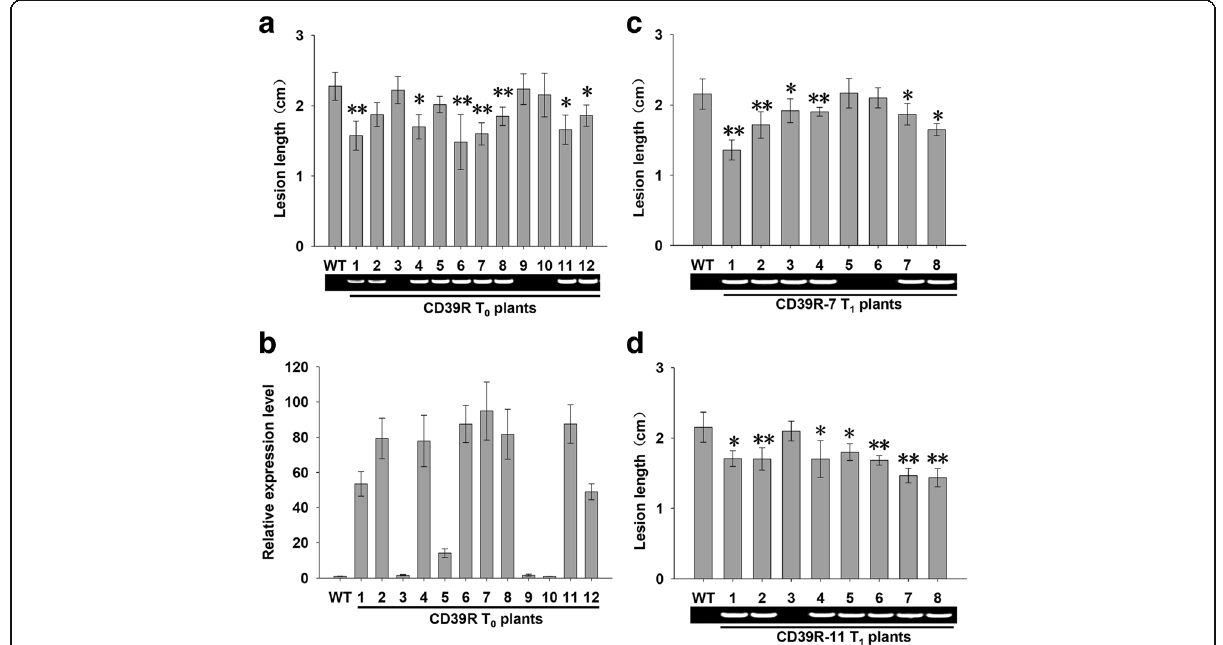
Fig. 2 Resistance of OsHsp18.0-CI -overexpressing plants to the Xoc strain RS105. a Lesion lengths of the 12 individual T 0 transgenic plants with pU1301:: OsHsp18.0-CI (CD39R) at 14 days post inoculation (dpi). b Relative expression levels of OsHsp18.0-CI in the T 0 transgenic plants. c and ( d ) Resistance of two OsHsp18.0-CI -overexpressing lines (CD39R-7 and CD39R-11) to Xoc in the T 1 generation. The average lesion length for each plant was measured at 10 to 15 inoculation sites at 14 dpi. The gel graph indicates the plants carrying pU1301:: OsHsp18.0-CI that were validated by PCR. The bars represent the means±SD. “ * ” and “ ** ” indicate significant ( t test, P <0.05) and extremely significant ( t test, P <0.01) differences in lesion lengths between wild-type and transgenic plants,